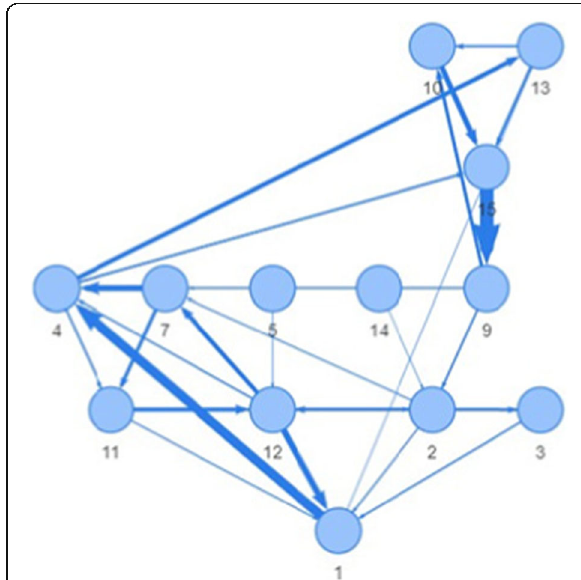
Fig. 5 A hierarchical layout of a node-link diagram shows the graph nodes on horizontal